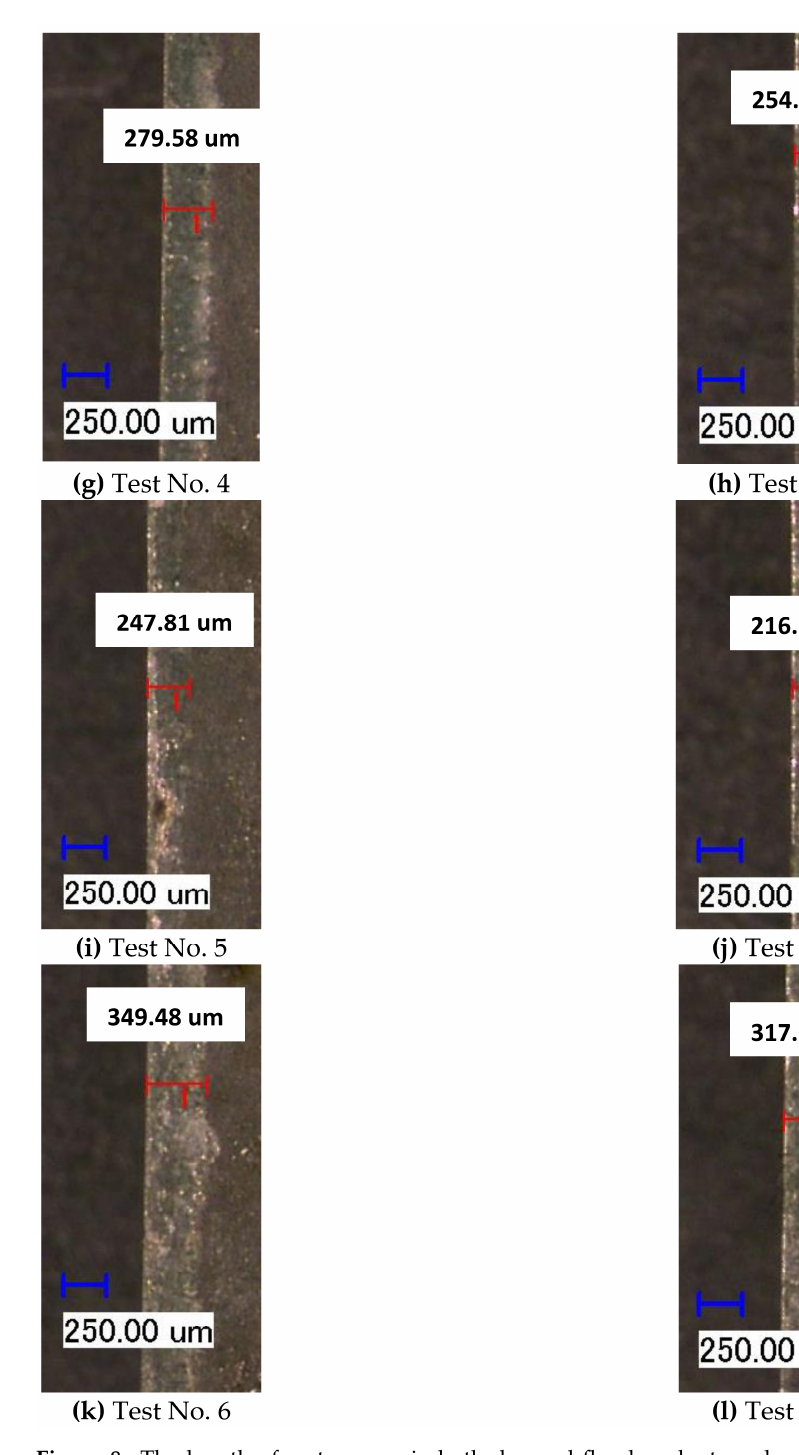
Figure 8. The length of crater wear in both dry and flood-coolant modes for all the six cutting conditions.